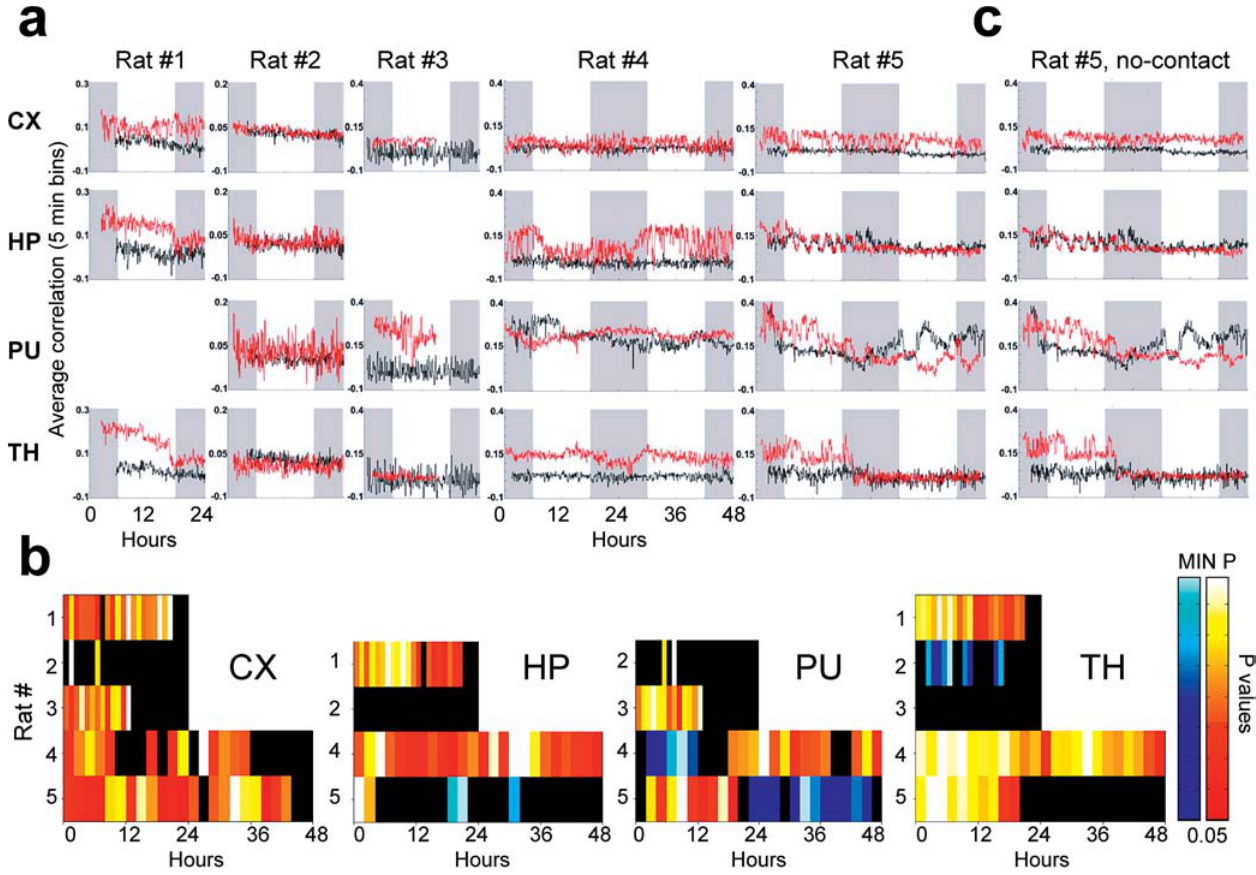
Figure 3. Long-Lasting Neuronal Reverberation Occurs in the CX, HP, PU, and TH (A) Temporal profiles of neuronal ensemble correlations in all recording sites. Gray bands indicate lights-off; white bands indicate lights-on. Red and black traces indicate post- and prenovelty correlations, respectively. (B) Temporal evolution of p values associated with pre- and postnovelty Bonferroni comparisons for individual brain areas, calculated as in Figure 2C. Color bar in linear scale; black denotes p . 0.05. Minimum p values (MIN P) in crescent ‘‘ rat number ’’ order, as follows: CX: 10 (cid:1) 10 , 10 (cid:1) 4 , 10 (cid:1) 5 , 10 (cid:1) 9 , 10 (cid:1) 9 ; HP: 10 (cid:1) 12 , not significant, 10 (cid:1) 22 , 10 (cid:1) 3 (both red and blue scales); PU: 10 (cid:1) 2 , 10 (cid:1) 12 , 10 (cid:1) 15 (blue scale) and 10 (cid:1) 17 (red scale), 10 (cid:1) 16 (red scale) and 10 (cid:1) 34 (blue scale); TH: 10 (cid:1) 18 , 10 (cid:1) 3 (blue scale), not significant, 10 (cid:1) 30 , 10 (cid:1) 16 . (C) Neuronal ensemble correlations for no-contact templates (taken from epochs within the novel stimulation period in which animals had no sensory contact with the novel objects) also show enhanced neuronal reverberation. DOI: